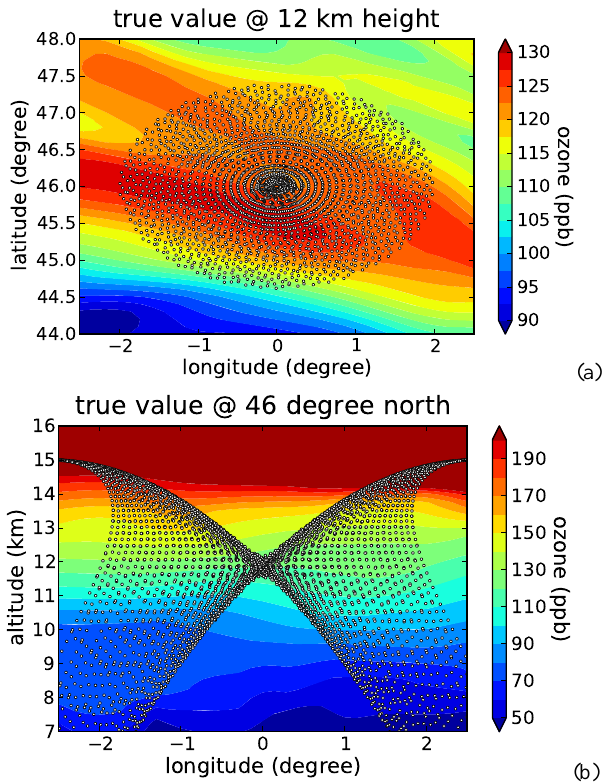
Fig. 3. Two cuts through the full 3-D true atmospheric state. (a) Shows the ozone filament at 12km height, while (b) shows a vertical cut along 46 ◦ N. Tangent points close to the cut planes are shown as small white